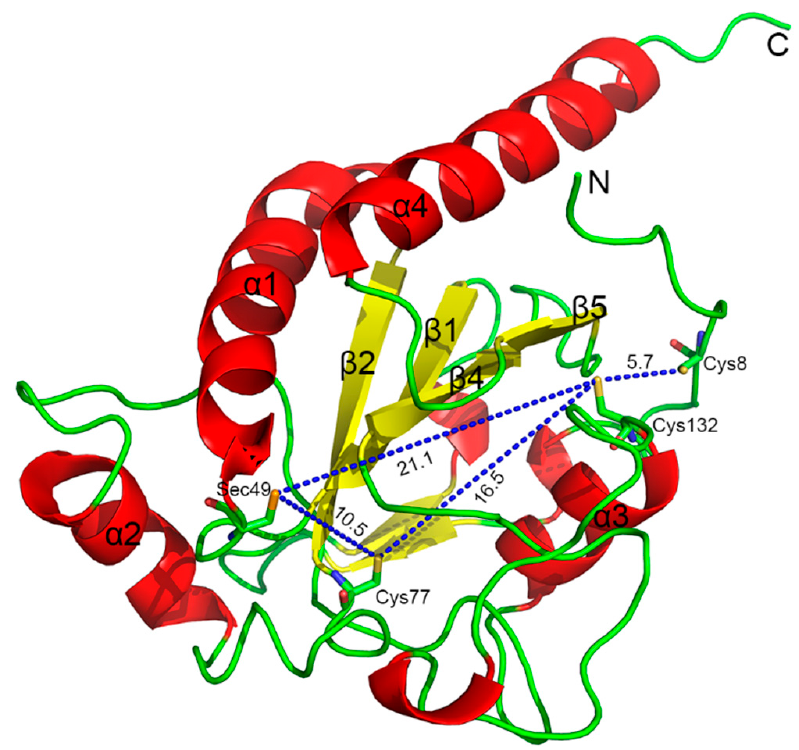
Figure 4. The overall structure of Sec − hGPx3 with the external N − terminal peptide; Cys8, Cys77, Cys132, and the catalytic center Sec49 are shown as sticks and labeled. The distances were measured and are shown by blue dotted lines and labeled. Cartoon representations were generated in PyMOL .